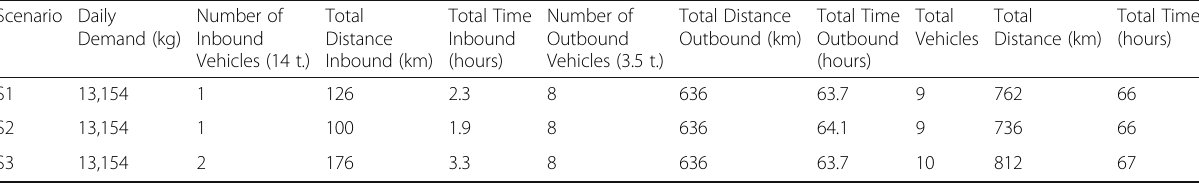
Table 4 Travelled distances and times for the three assessed scenarios calculated by ANNONA Scenario Daily Number of Demand (kg) Inbound Vehicles (14